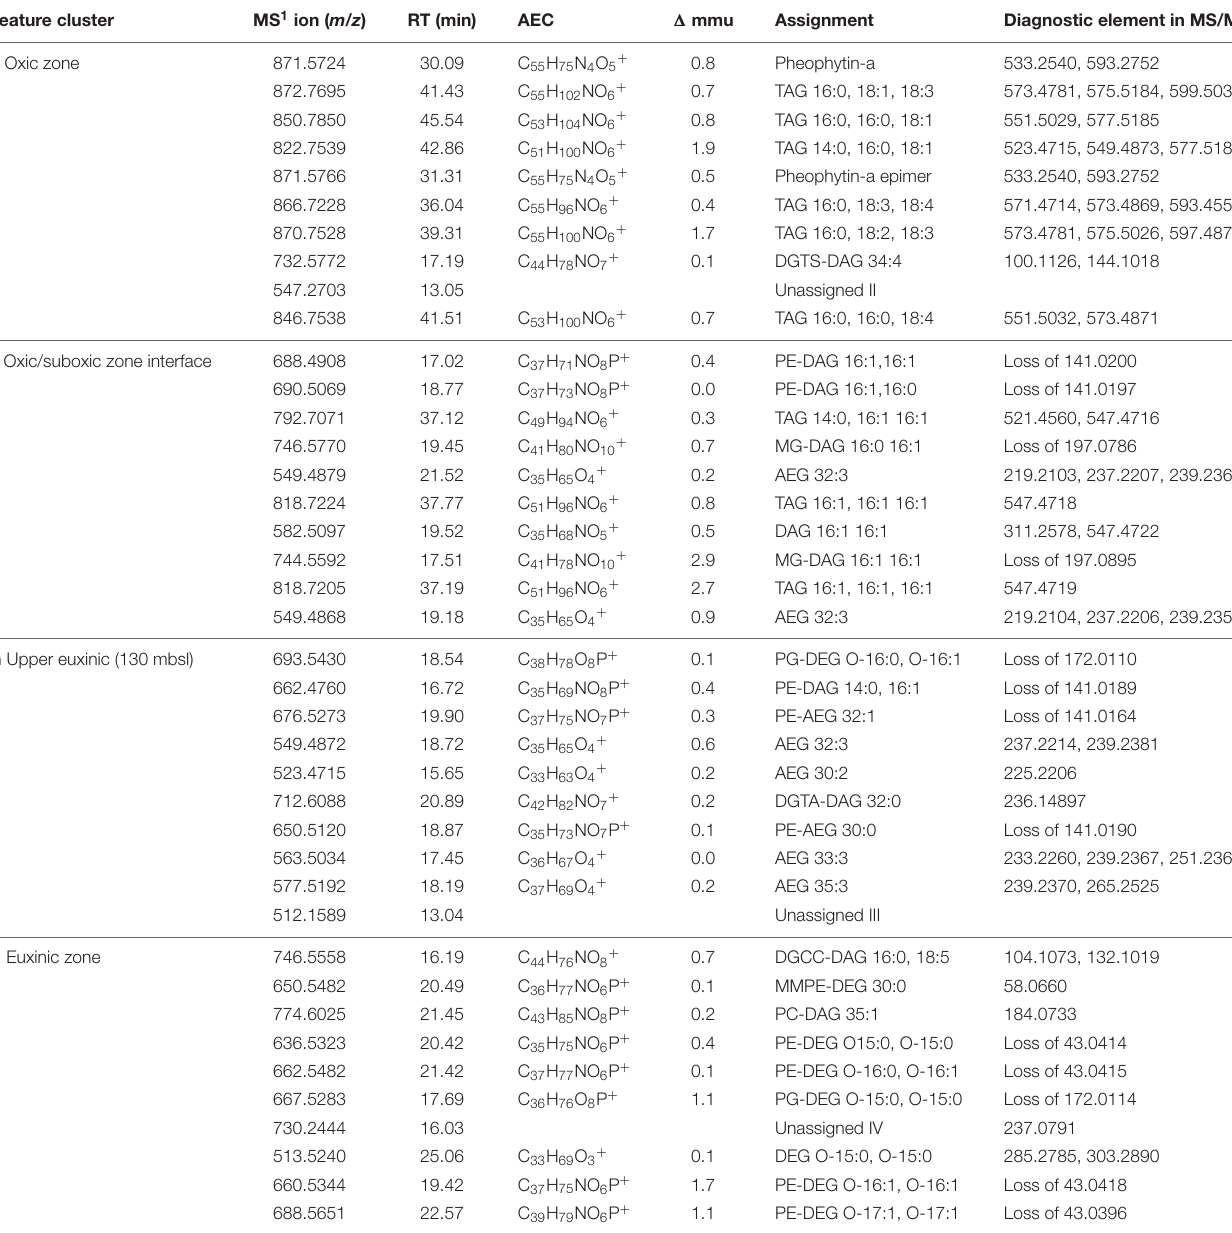
TABLE 4 | The most abundant components of cluster E–H in the Black Sea SPM extracts (2017 expedition). Feature